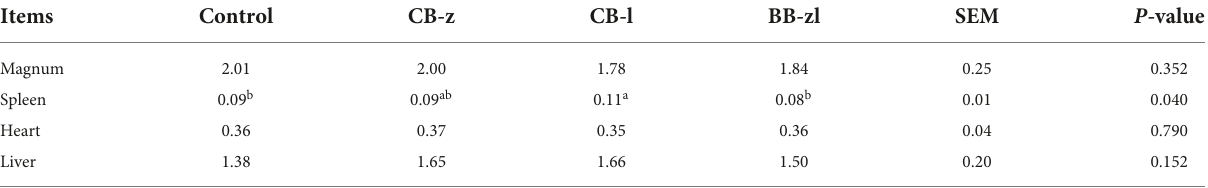
TABLE 7 Effects of Clostridium butyricum and Brevibacillus sp. on the organ index of laying hens.